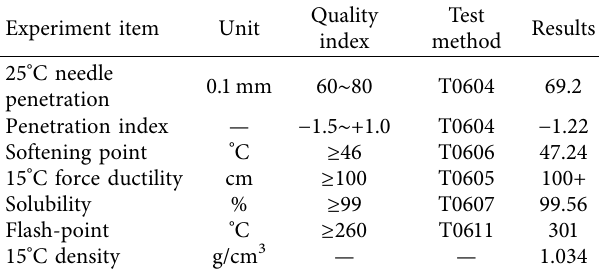
Table 1: Main technical indexes of base